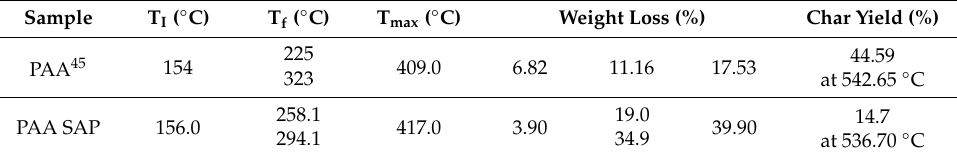
Table 11. Characteristic decomposition temperatures of P (AA / Kry23-DM)